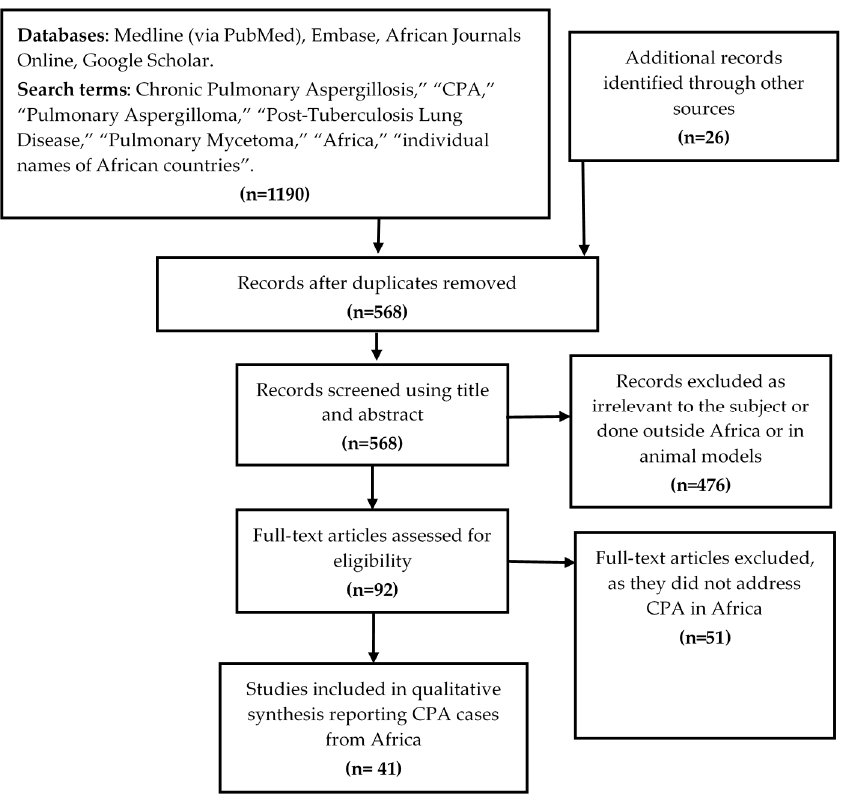
Figure 1. Citation selection process for the systematic review. Forty-one articles were found de- scribing CPA cases in Africa.